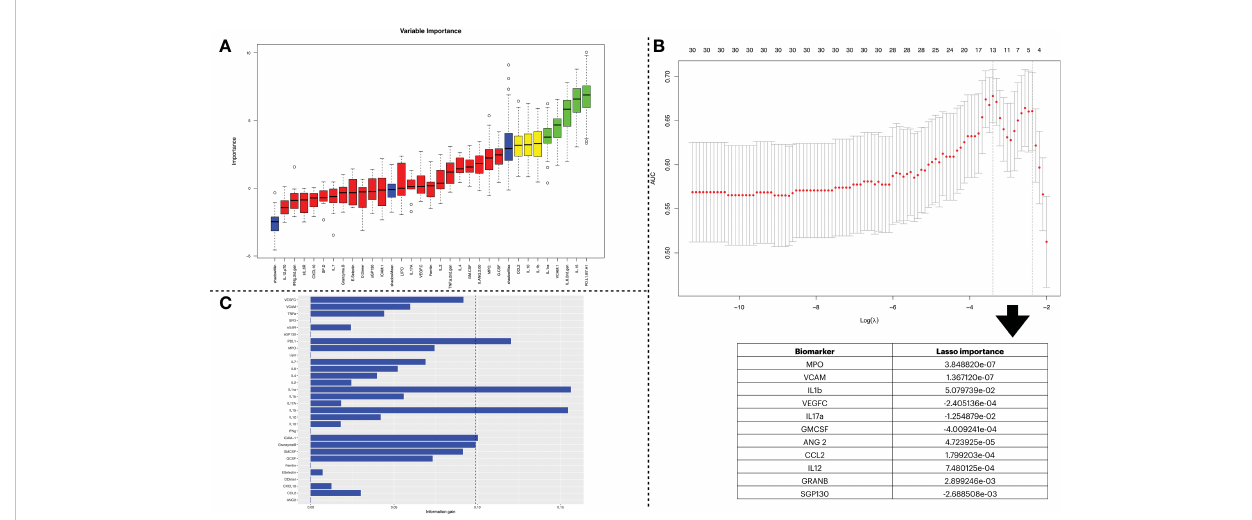
FIGURE 3 Biomarker selection using three feature selection algorithms. (A) indicates the feature selection process using the Boruta algorithm. The fi rst set of obtained variables was submitted to a tentative fi x method to deliver a more reliable subset. In the plot, the columns shown in green are the ones con fi rmed by the algorithm to be statistically signi fi cant and have higher importance in describing the data ’ s label. (B) shows the results obtained by the feature selection using Lasso Regression. The x-axis of the fi gure indicates the log of lambda. Since Lasso Regression might be used as a classi fi cation model, the y-axis shows the AUC when including the number of variables shown at the top of the plot. The table below shows the variables stored in the lasso$lambda.min object, which corresponds to the variables with the best lambda values. The more distant a value is from zero, the more relevant it is for the predictor once that Lasso Regression sets the lambda = 0 to unimportant variables. (C) conveys the information gain derived from dataset entropy reduction achieved by the Information Gain algorithm. The vertical dashed line represents a threshold that considered the fi ve most impactful